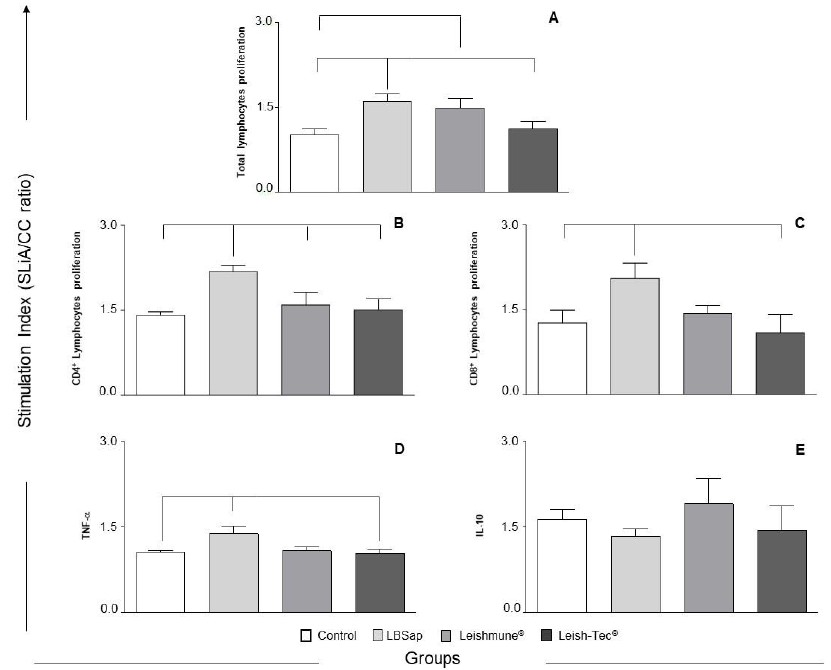
Figure 4. Cell proliferation response of peripheral blood mononuclear cells (PBMCs) after stimulation with soluble L. infantum antigen (SLiA) and profile of cytokine production in the culture supernatant of dogs submitted to different vaccination protocols. The x -axis displays the groups: C (control;